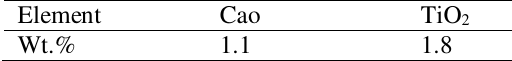
Chemical analysis of Al 2 O 3 wt%.[8]. Element Cao TiO 2 Fe 2 O 3 Wt.%